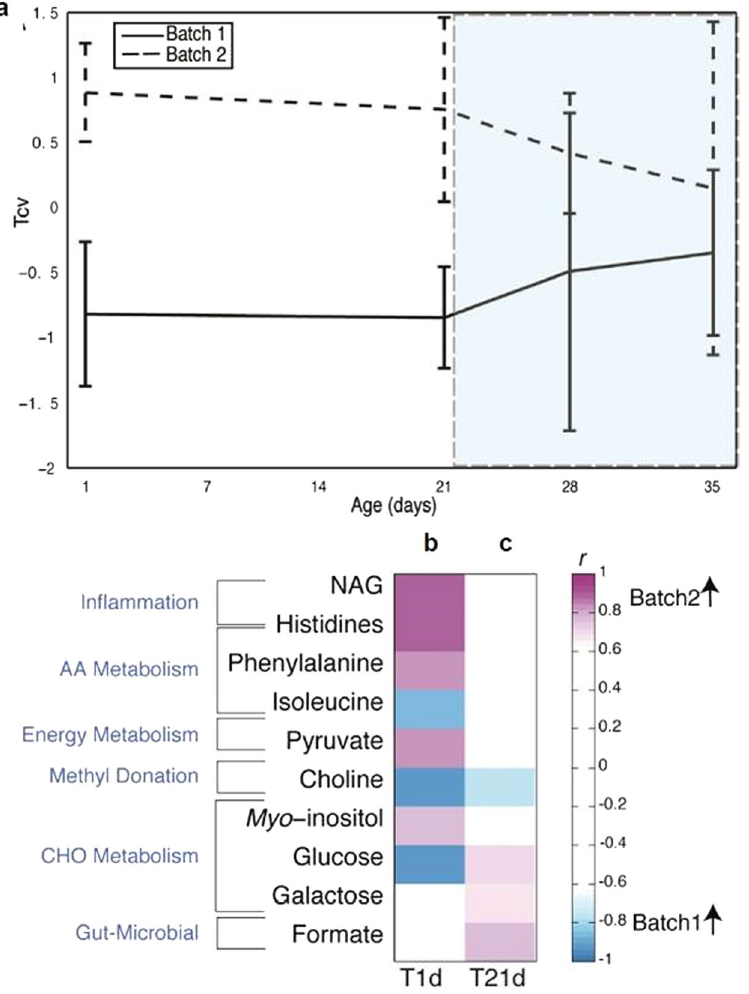
Figure 2. Batch effects are observed in the metabolic profile of serum at 1d. ( a ) Serum was analysed by 1 H NMR spectroscopy and a pairwise comparison was made by O-PLS-DA (uv scaling), between the two experimental batches (n = 6) and the mean of the cross-validated scores (Tcv) from each model ( + / − standard deviation) are plotted at 1, 21, 28 and 35 days. Post-weaning period depicted by blue shading. ( c ) Significant correlation coefficients ( r > + / − 0.6) were extracted from these pairwise models and displayed as a heatmap for the model at 1d ( b ) and at 21d ( c ). Metabolites coloured in increasing shades of purple are significantly increased in batch 2 and metabolites ordered by metabolic pathway. Abbreviations: AA–amino acid; CHO– carbohydrate; NAG– N -acetyl